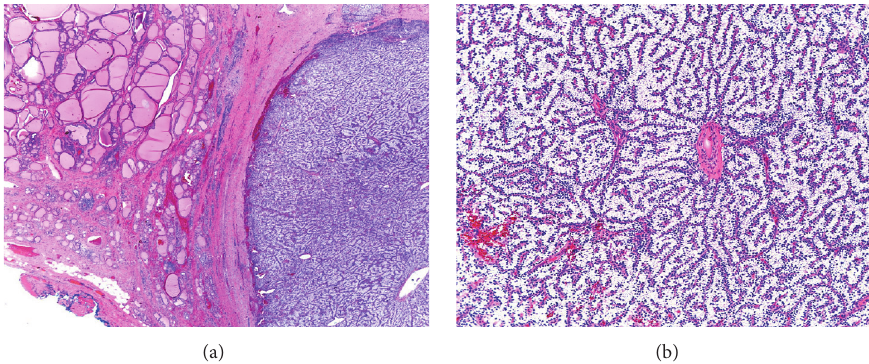
Figure 3: (a) Normal thyroid tissue on the upper left corner, (b) parathyroid neoplasm on the water-clear cell adenoma.